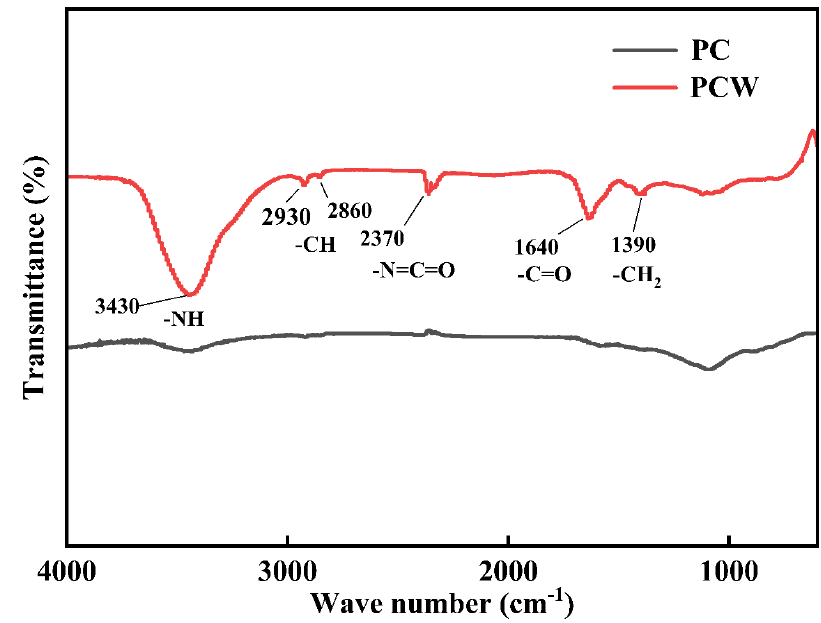
Figure 5. TIR spectra of PC and PCW.